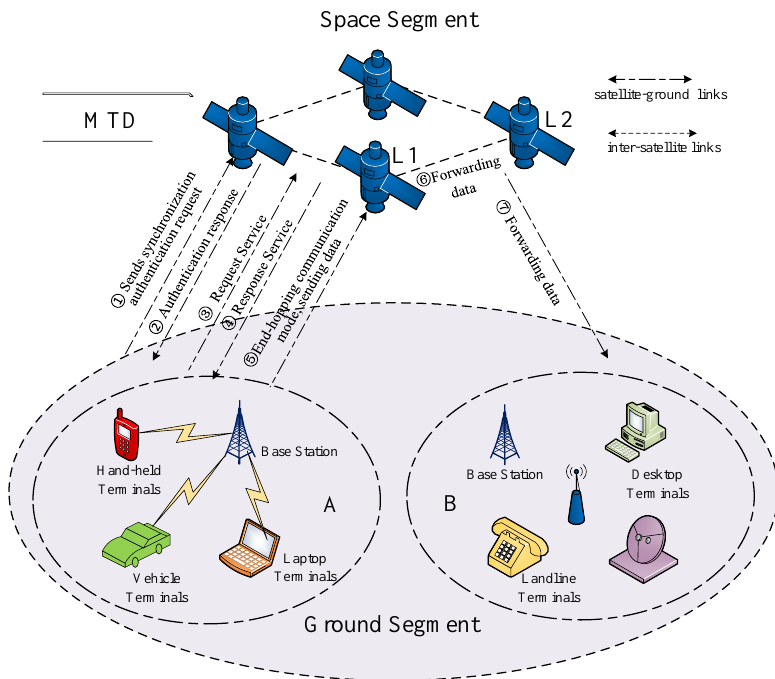
Figure 7. Communication scenario for the satellite network security protection system based on Moving Target